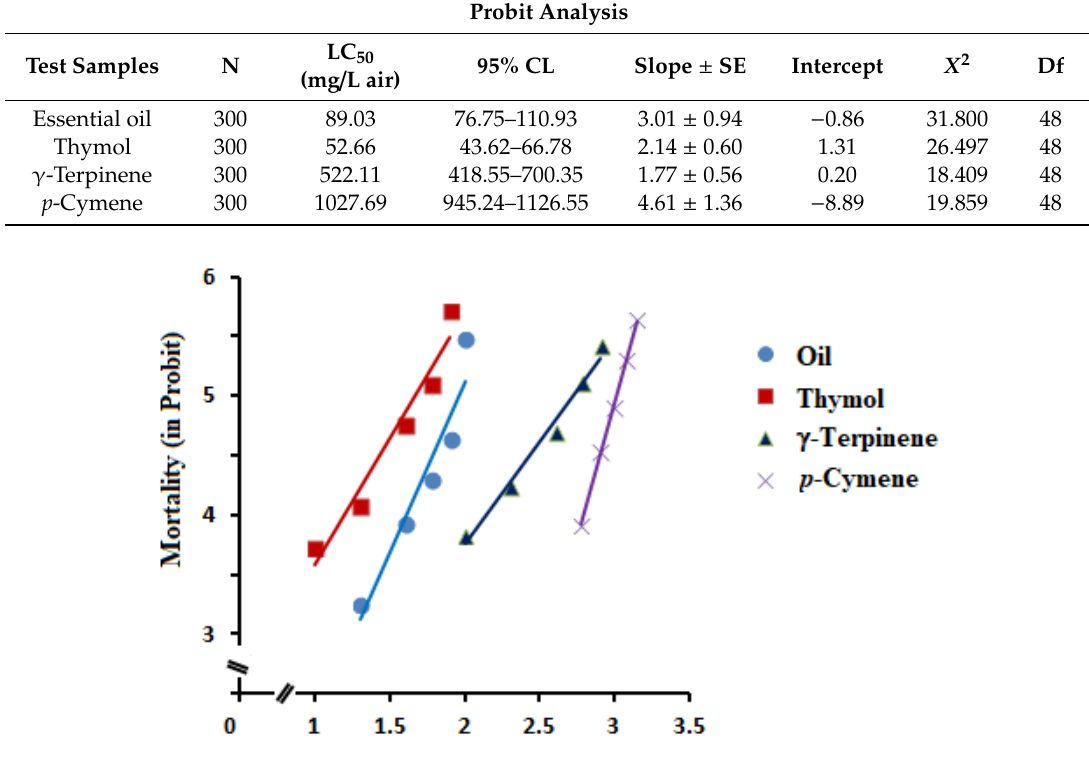
Figure 3. Concentration-response lines of fumigant mortality of Trachyspermum ammi essential oil and its three main constituents (thymol, -terpinene, and p -cymene).